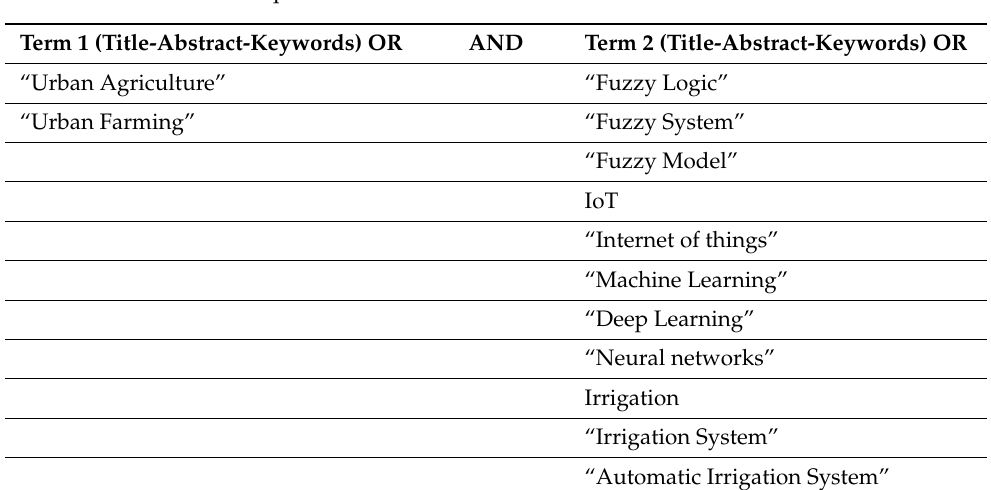
Table 3. The third search